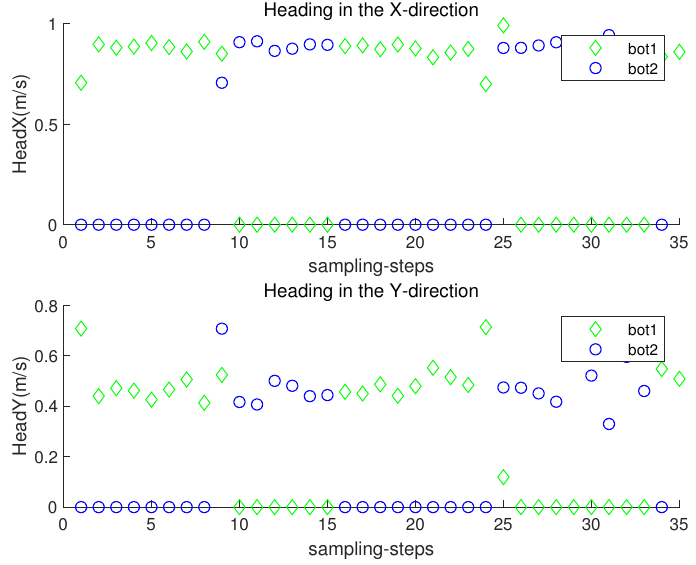
Figure 6. Scenario 1. head x and head y with respect to